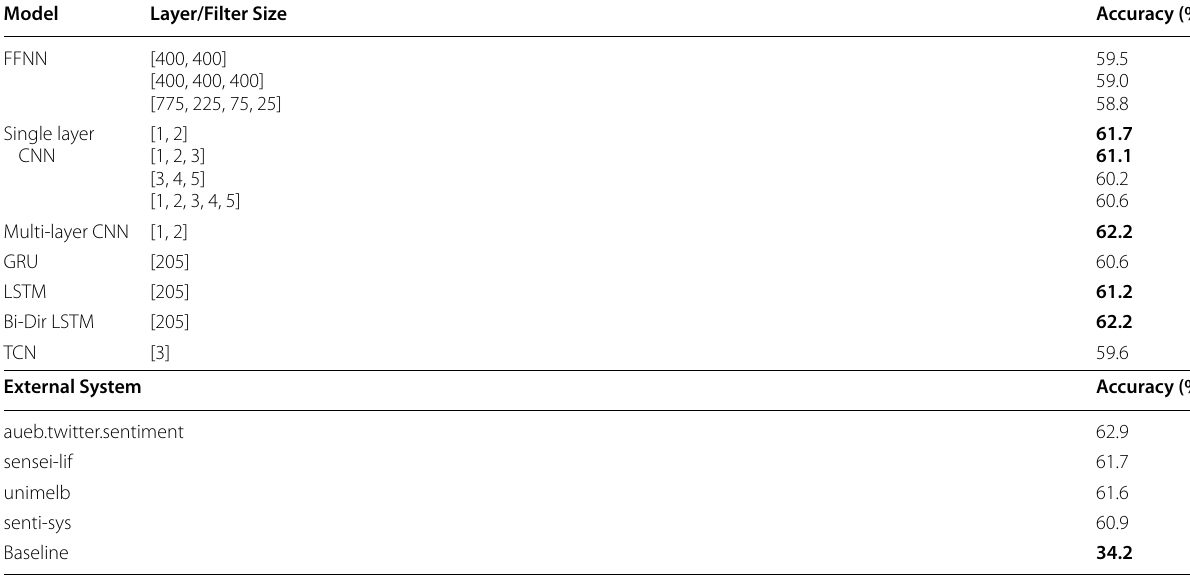
Table 4 Accuracy results SemEval-2016 dataset. Results of the external systems from the SemEval-2016: task a competition are compared with the results of the neural network models presented in the current body of work. While a total of 34 systems contributed to the competition, only four systems are illustrated in descending order for comparison [52] Model